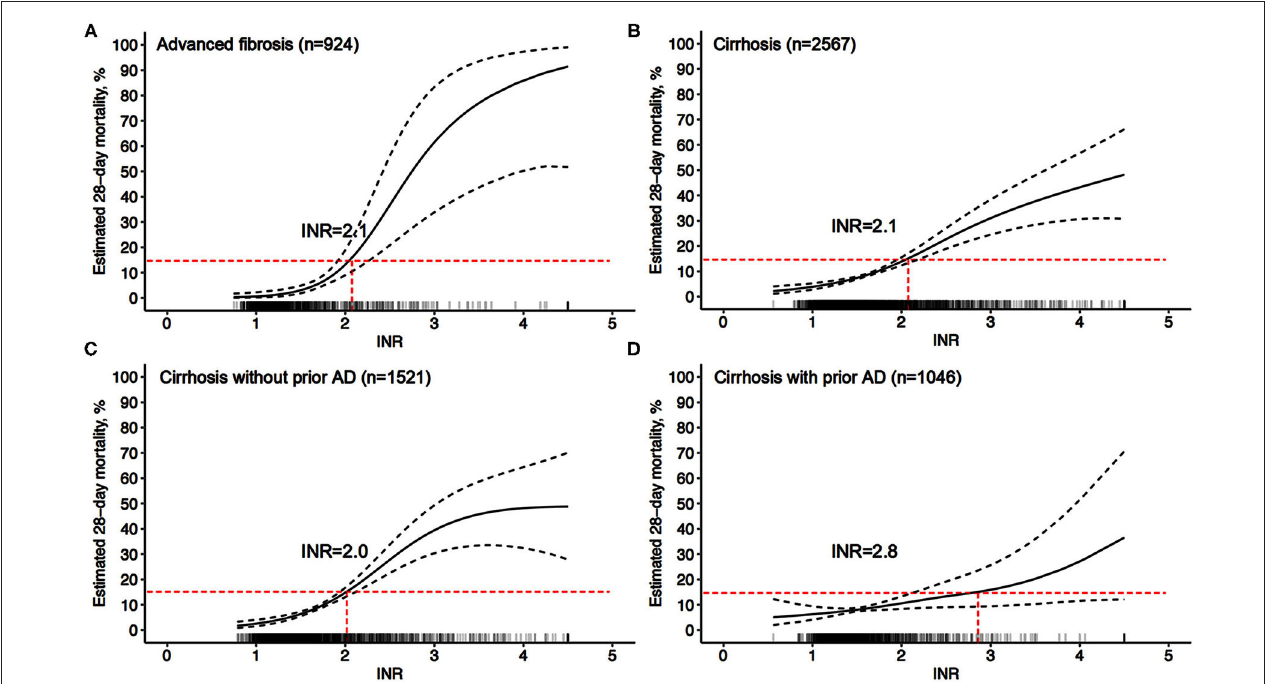
FIGURE 6 | Adjusted probability of INR-mortality (28-day) correlation curves. (A) adjusted (age, gender, etiology, HE grades, ascites, infection, TB, and Cr) probability of the INR-mortality (28-day) correlation curve in advanced fibrosis, (B–D) adjusted (age, gender, etiology, HE grades, ascites, infection, gastrointestinal bleeding, TB, and Cr) probability of the INR-mortality (28-day) correlation curve in cirrhosis (B) , in cirrhosis without prior AD (C) , and in cirrhosis with prior AD (D) . TABLE 4 | Multivariable adjusted 28- and 90-day LT-free mortality based on the starting point of INR for disease deterioration and clinical INR cutoffs in cirrhosis and advanced fibrosis. Meaning of Value of Number of patients 28-day LT-free 90-day LT-free INR cutoff cutoff exceeding cutoff (%) mortality (%) mortality (%) Cirrhosis Peak of acceleration curve 1.6 40.2% (1033/2567) 8.5% 16.2% Valley of acceleration curve 2.6 8.4% (215/2567) 24.7% 34.7% Reaching 15% 28-day LT-free 2.1 17.4% (447/2567) 25.1% mortality (clinical cutoff) 1.6–2.1 Advanced fibrosis Peak of acceleration curve Valley of acceleration